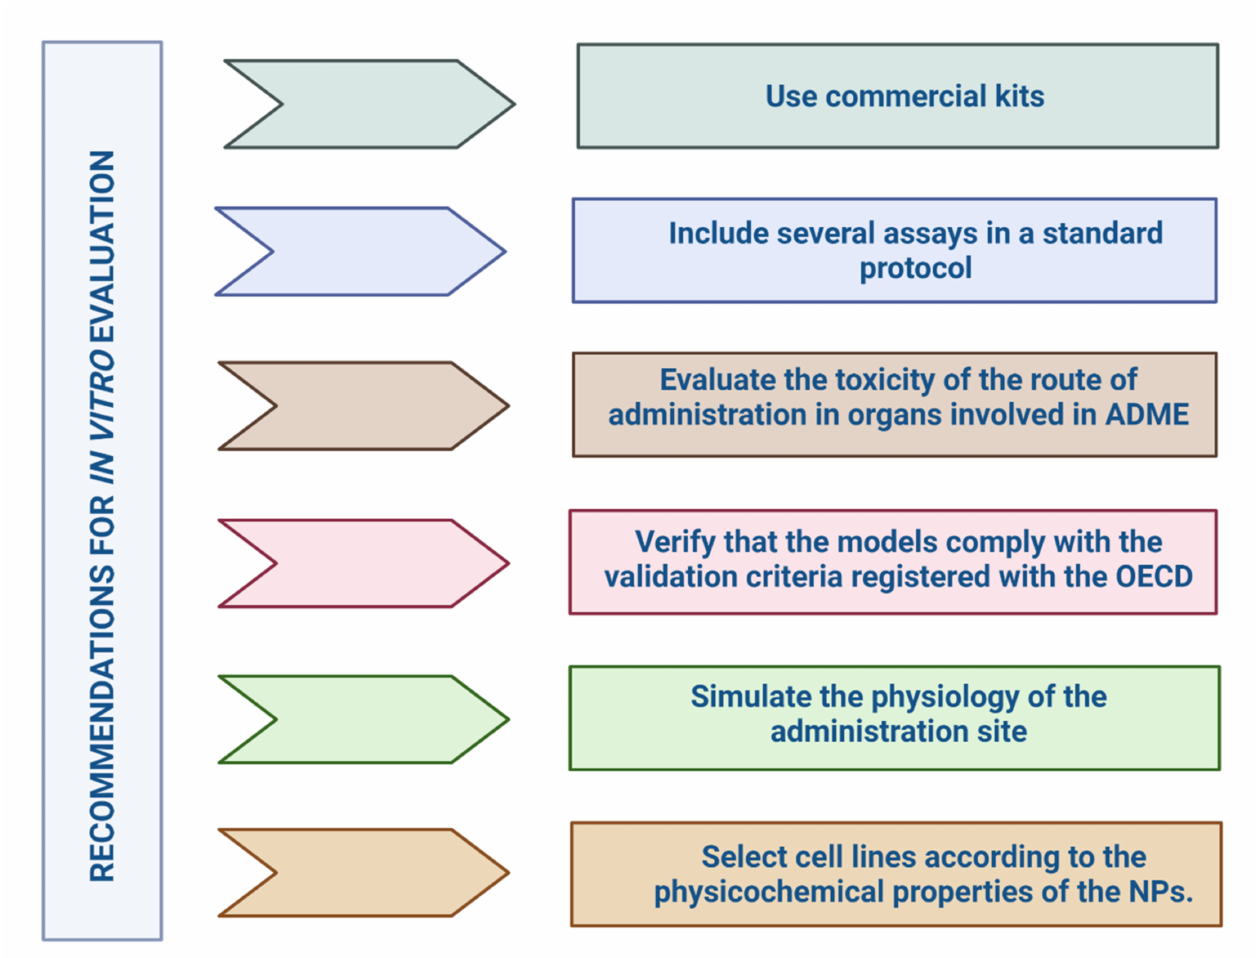
Figure 5. Recommendations for evaluating NPs in in vitro systems. ADME: Absorption, Distribution, Metabolism, and Excretion; OECD: Organisation for Economic Co-operation and Development. Created with BioRender.com (accessed on 10 December